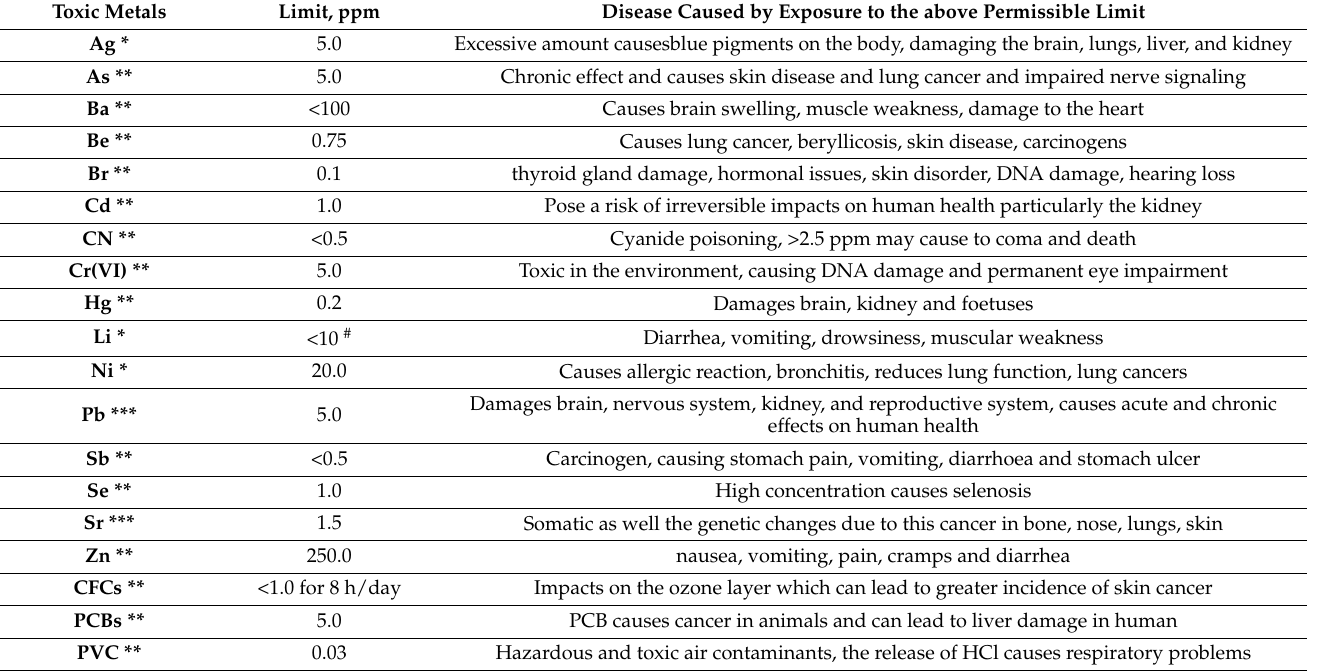
Table 2. The adversities related to different metal contents in industrial wastes